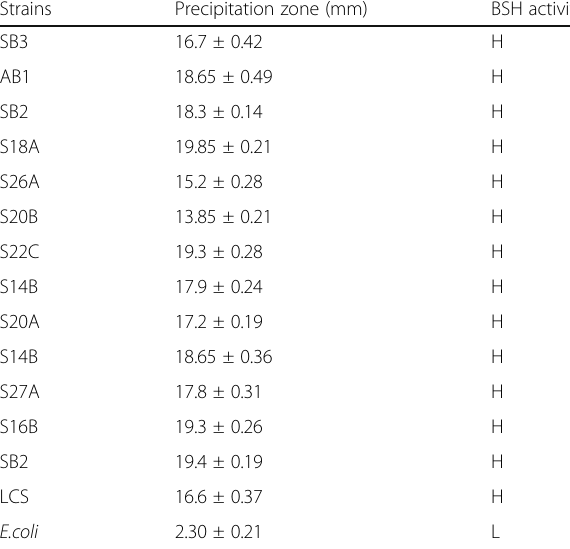
Table 4 Amylase and protease enzyme production by